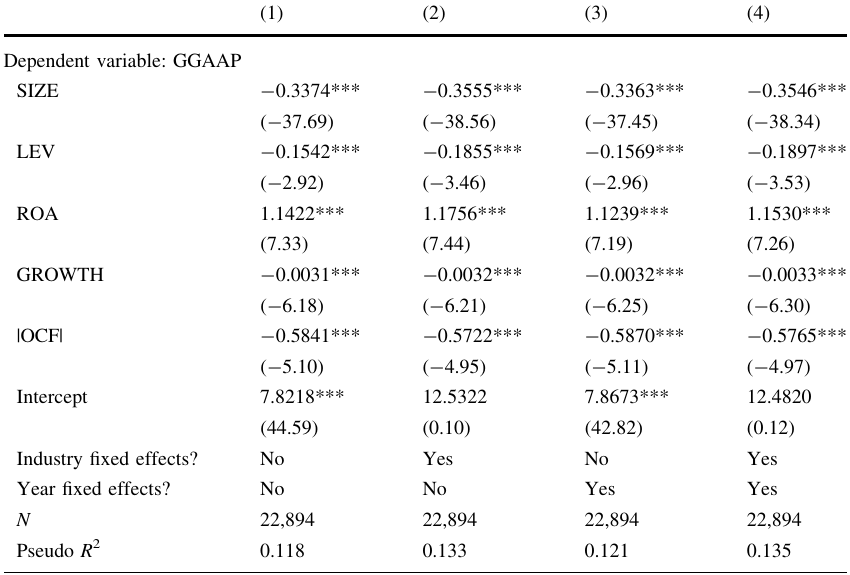
Table 5 First-stage regression—probit